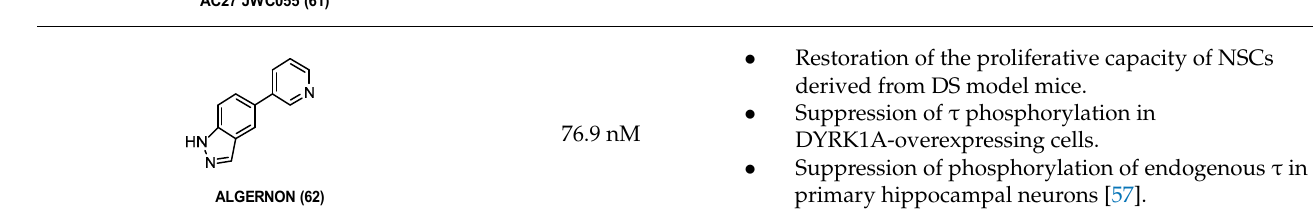
Chemical tools for DYRK1A-mediated diseases. Inhibition of DYRK1A-induced τ phosphorylation at multiple AD-relevant sites (Ser396, Thr212, Thr231). Normalization of A β -induced τ phosphorylation in neuronal cells. Normalization of DYRK1A-induced A β production in APP overexpressing cells